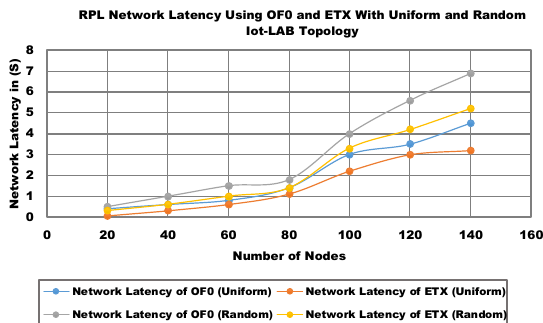
Figure 11. Latency comparison using OF0 and ETX with uniform and random IoT‐LAB testbed. (cid:4)